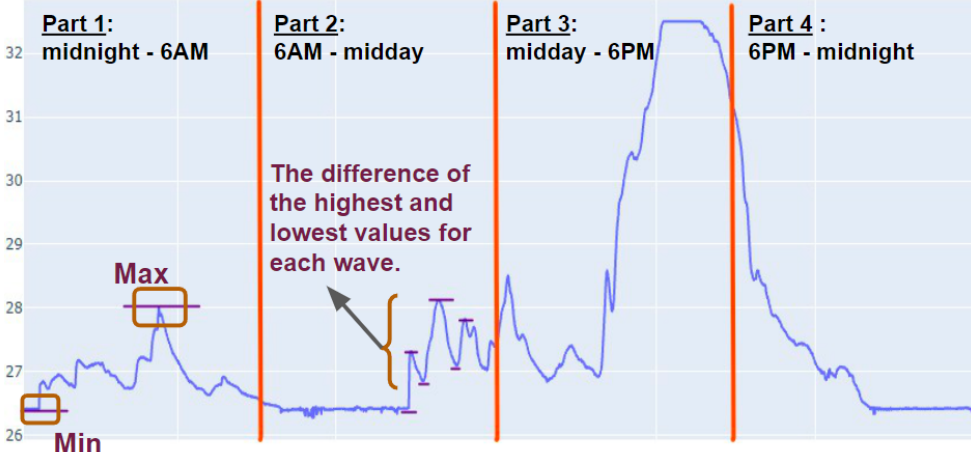
Figure 4. Examples of manually extracted features from a particular